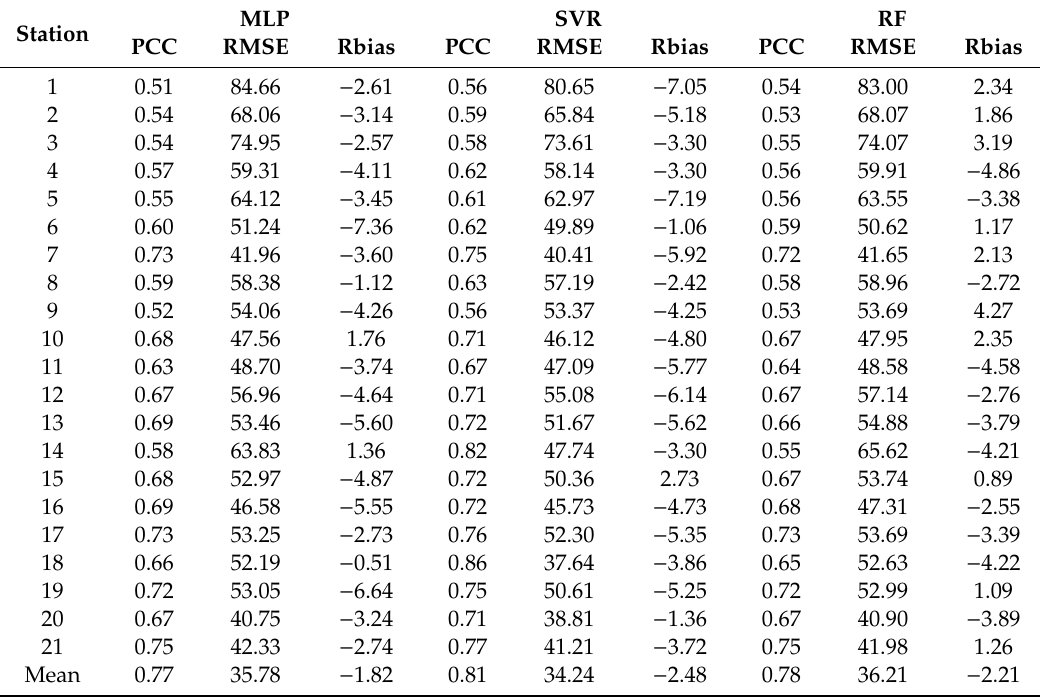
Figure 4. Size of selected principal components (PCs) for each station and the region mean. Table 6. Validation results of three ML methods for each station and the region mean. SVR: support vector regression, RF: random forest.